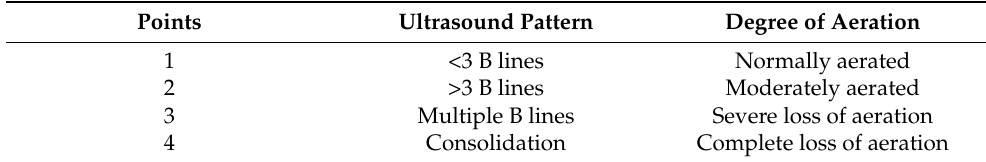
Table 1. Lung ultrasound score (LUS).